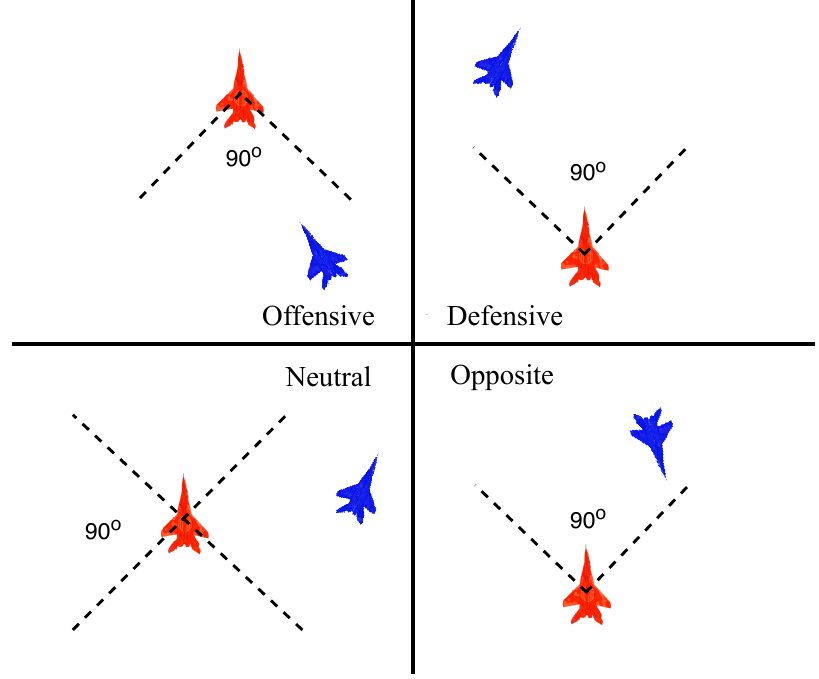
Figure 6. Four different initial conditions of the 1-vs.-1 WVR air combat